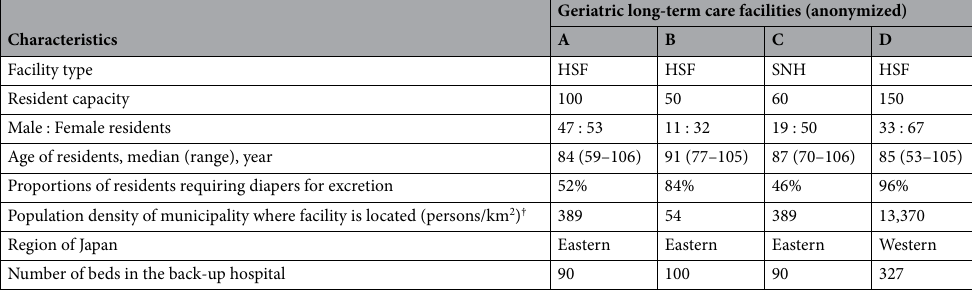
Table 1. Background characteristics of the study settings. HSF, health services facility; SNH, special nursing home. † Calculated using the populations of the municipalities in 2019 or